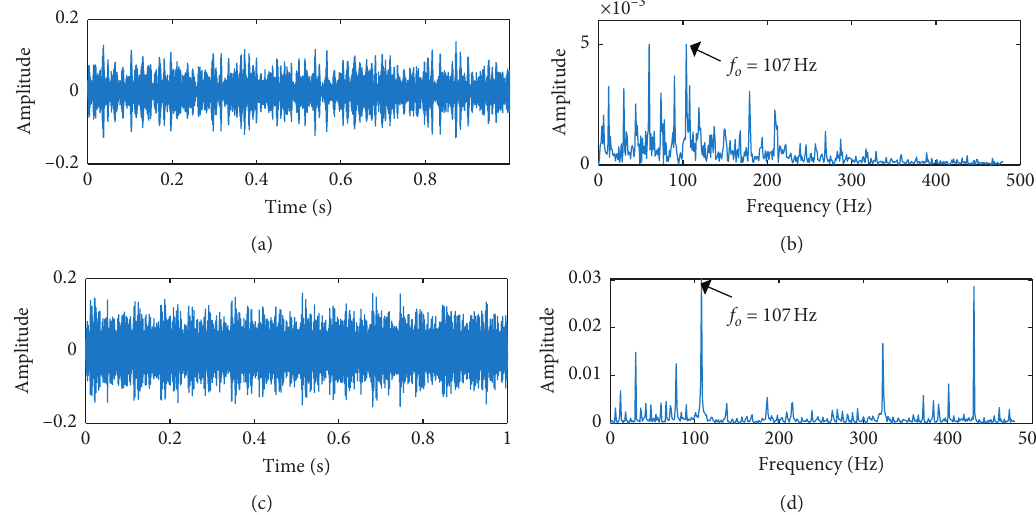
Figure 26: Results of the experimental signal in Figure 21(a) by different methods: (a) optimal mode extracted by the fixed-parameter VMD and (b) its envelope spectrum; (c) optimal mode extracted by PSO-based VMD and (d) its envelope